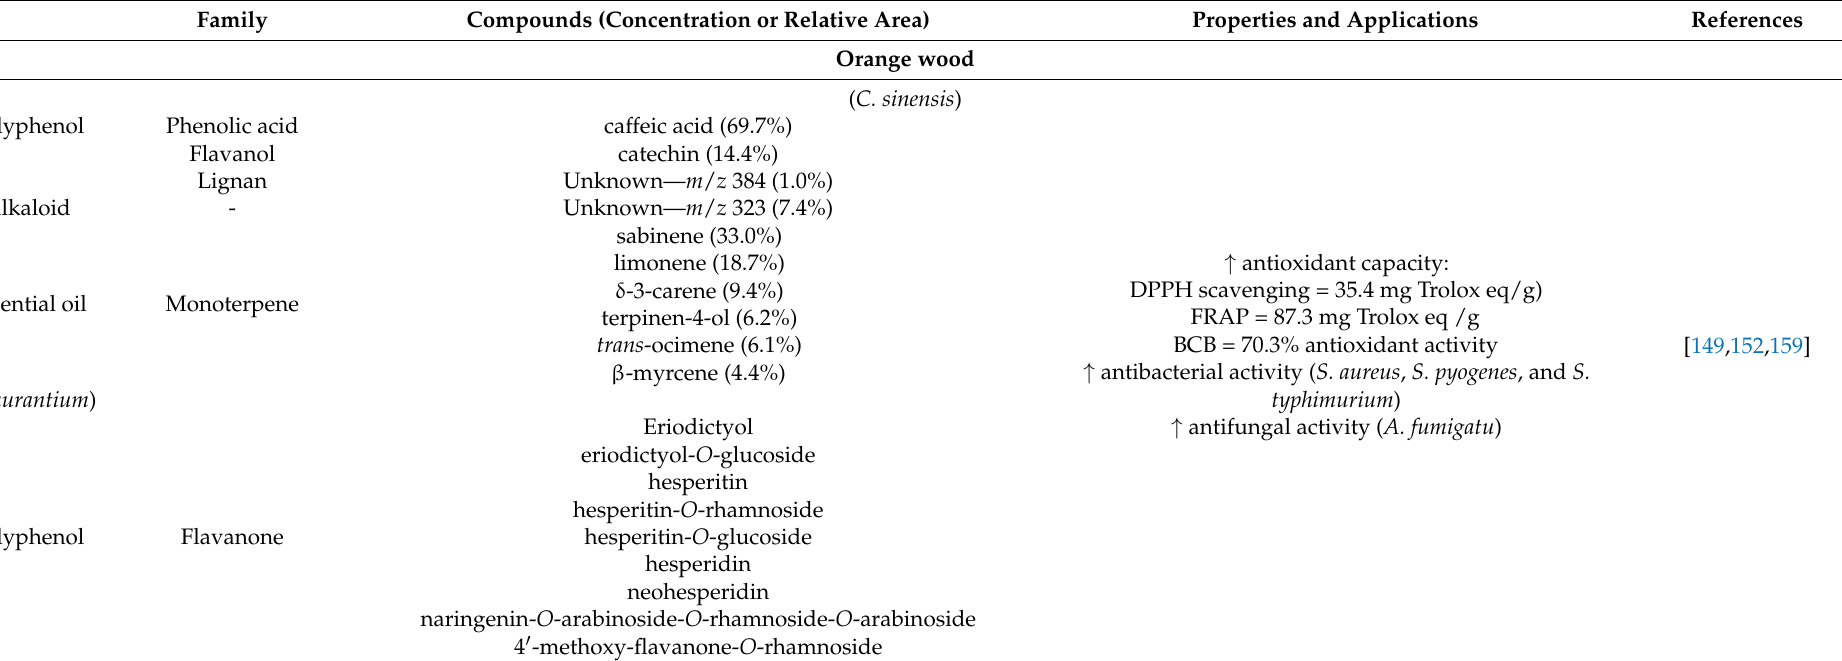
Table 6. Chemical composition, quantitation, major bioactivities, and applications of wood biomasses from citrus trees. * ↑ : Increase. Chemical structures by families are shown in Figure